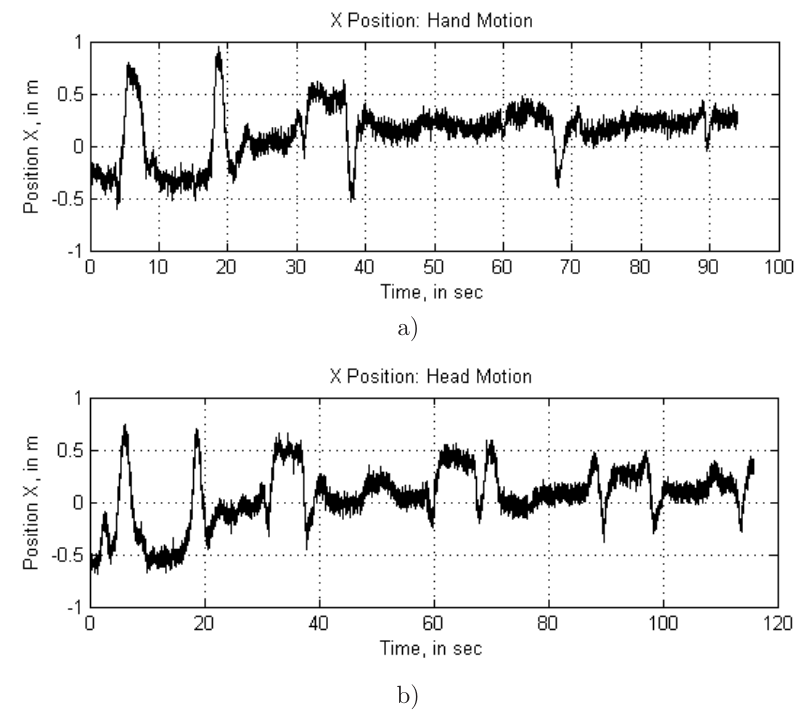
Figure 1. Example of real motion measurements with added Gaussian noise: X component of position measurements a) for hand and b) head